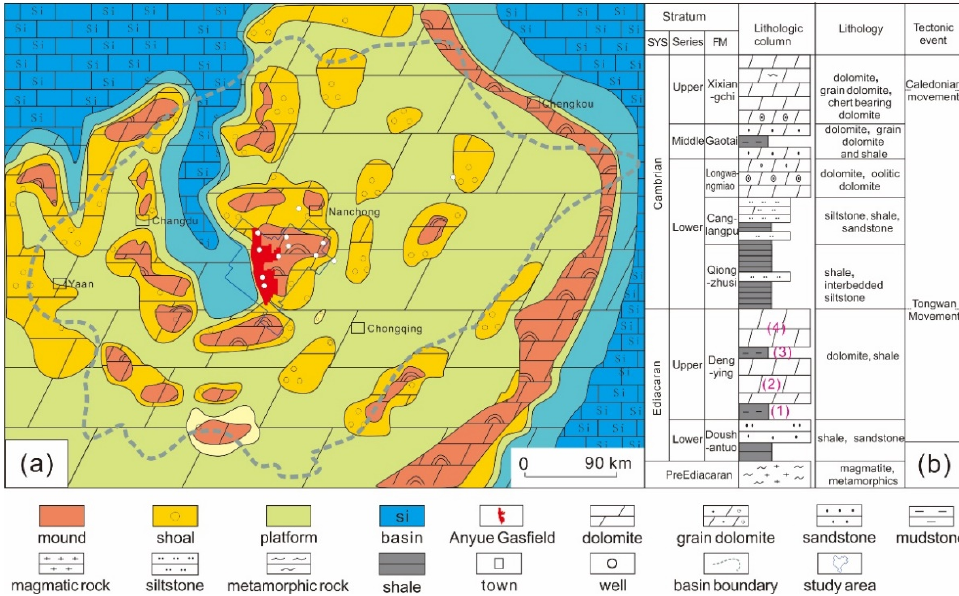
Figure 1. ( a ) The paleogeographic map of the Ediacaran Dengying Formation and ( b ) the strati- graphic column of the Ediacaran–Cambrian in the Sichuan Basin ((1)–(4): four members of Dengying Formation; SYS: System; FM: Formation; revised from references [20]).